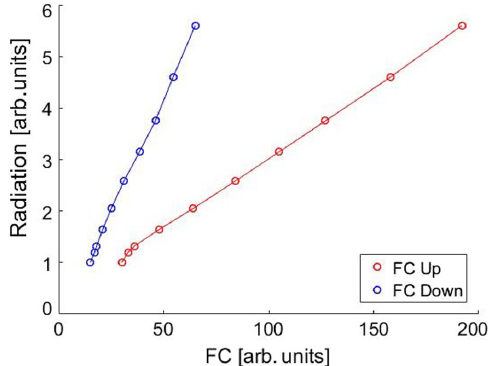
FIG. 15. Dependence of radiation level vs. upstream and downstream faraday cups signals at a pulse length of 1 . 2 μ s and an accelerating gradient of 70 MV =